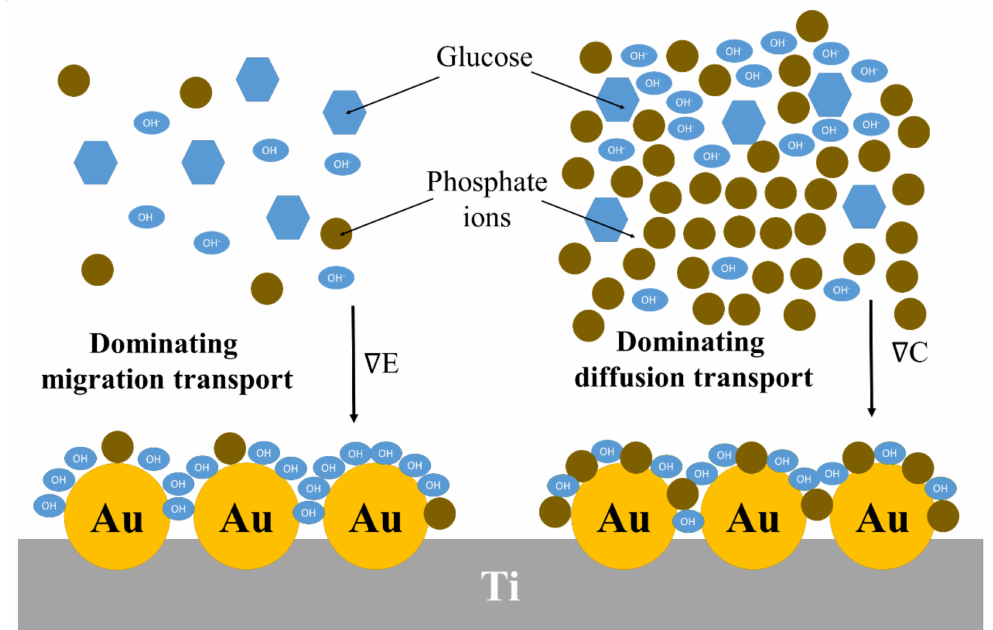
Figure 14. Schematic illustration of the e ff ect of the electrolyte concentration on the transport of hydroxyl ions towards the